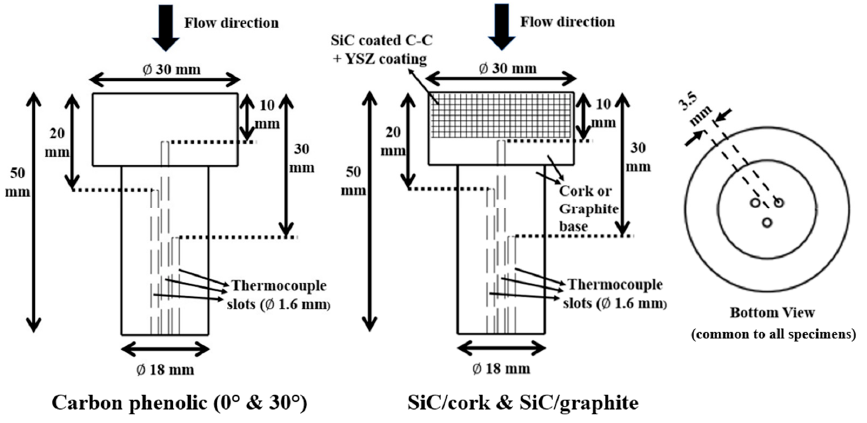
Figure 3. Specimen dimensions.